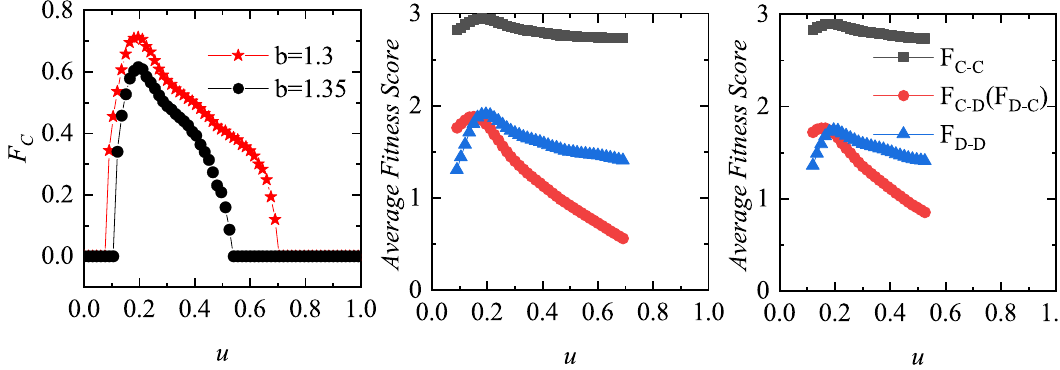
Figure 4. Left panel features the fraction of cooperators as a function of the punishment factor u . Middle and right panel features the averaged fitness of competing couples (the individuals whose neighbors hold different strategies) as a function of u for b = 1.3 and b = 1.35 , respectively. It is worth mentioning that when